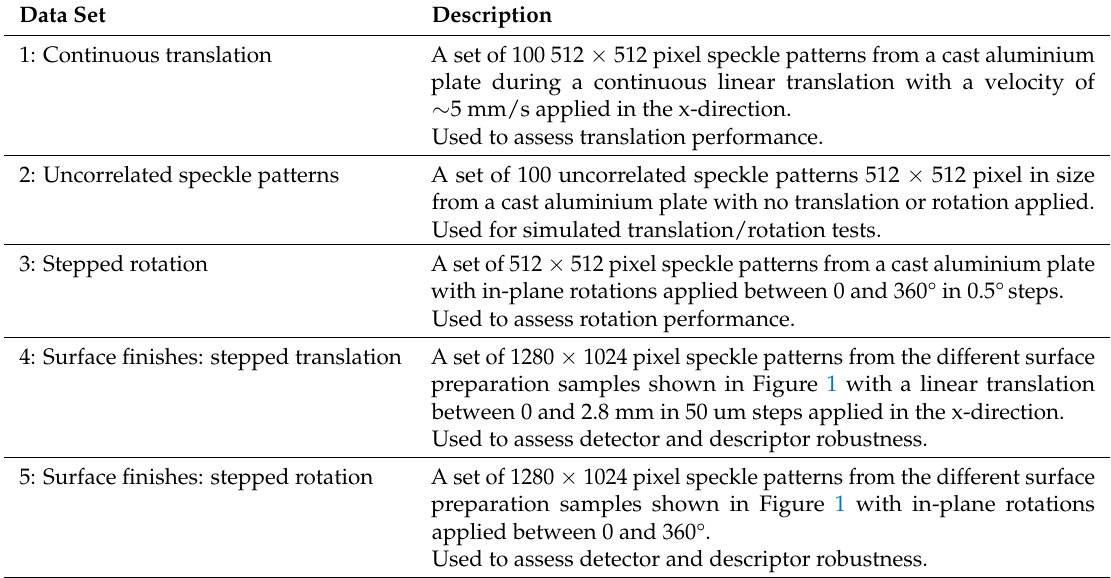
Figure 1. Surface finish samples with various surface roughnesses R z used together with a 250 × 100 pixel sub region of the resulting speckle pattern for each sample. Table 3. Summary of experimental data